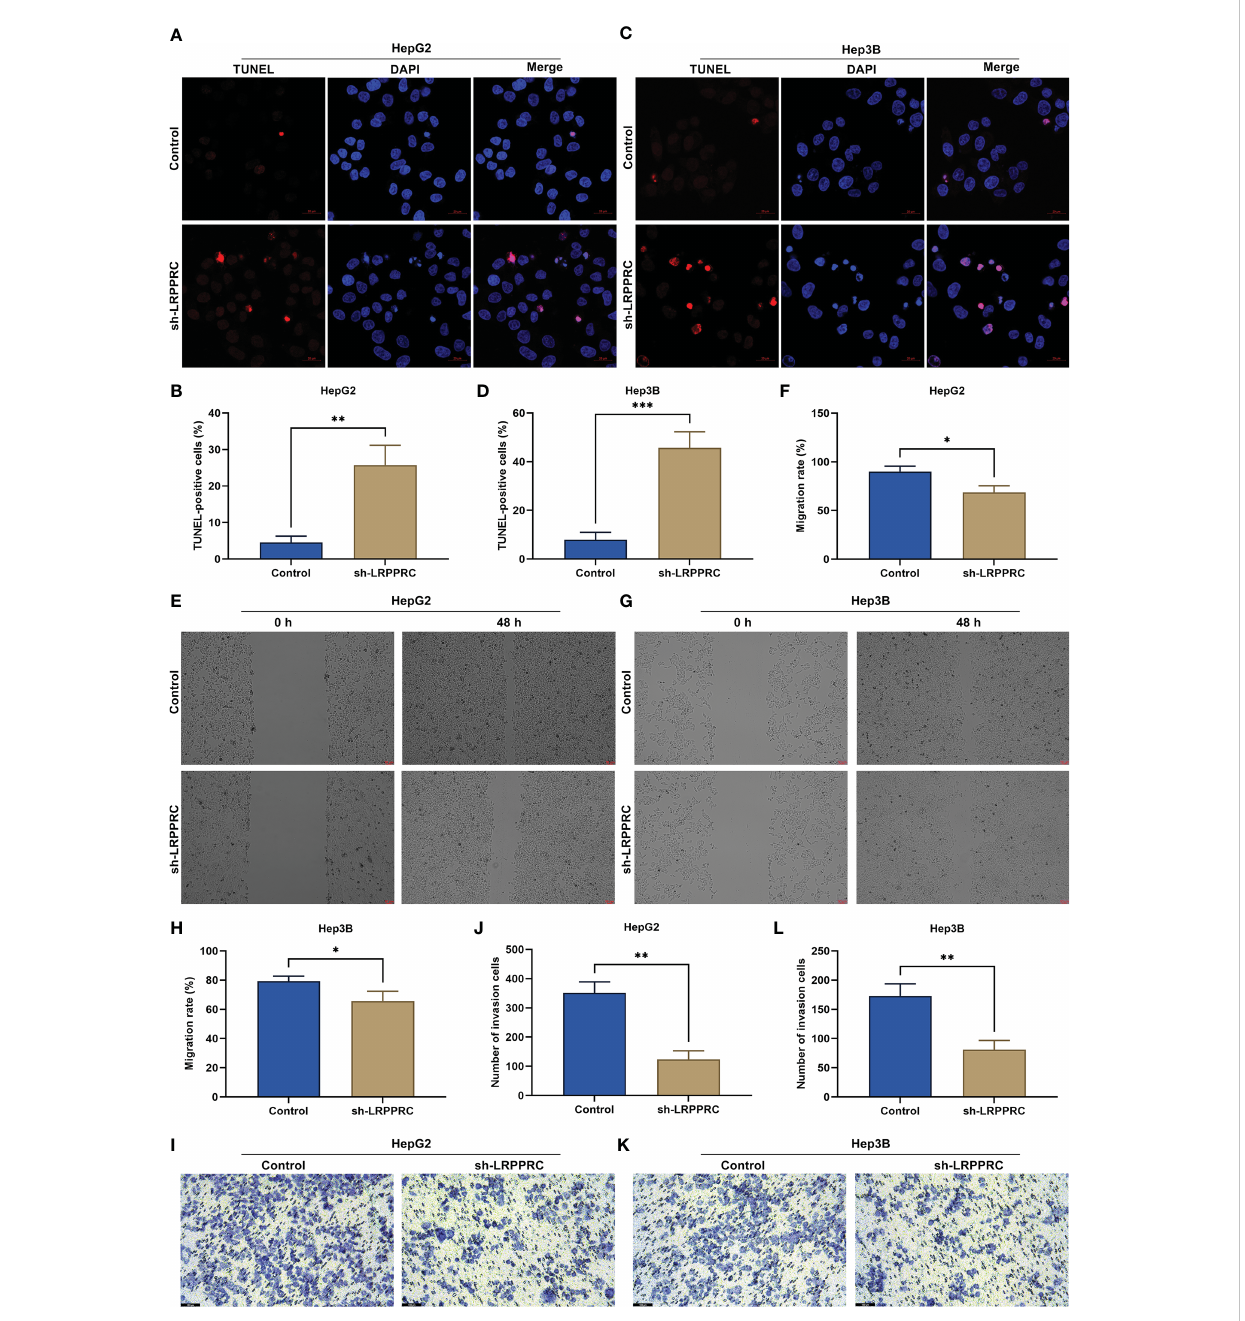
FIGURE 3 Leucine rich pentatricopeptide repeat containing (LRPPRC) loss results in apoptosis of hepatocellular carcinoma (HCC) cells and attenuates migratory and invasive abilities. (A – D) TUNEL (Terminal Deoxynucleotidyl Transferase mediated dUTP Nick-End Labeling) staining for the assessment of apoptotic level in LRPPRC-de fi cient HepG2 and Hep3B cells. Bar, 20 m m. (E – H) Wound healing test for investigating the migratory ability of HCC cells under the knockdown of LRPPRC. Bar, 50 m m. (I – L) Evaluation of the invasive capacity of LRPPRC-knockout HCC cells by use of transwell experiment. Bar, 100 m m. * p < 0.05; ** p < 0.01; *** p <